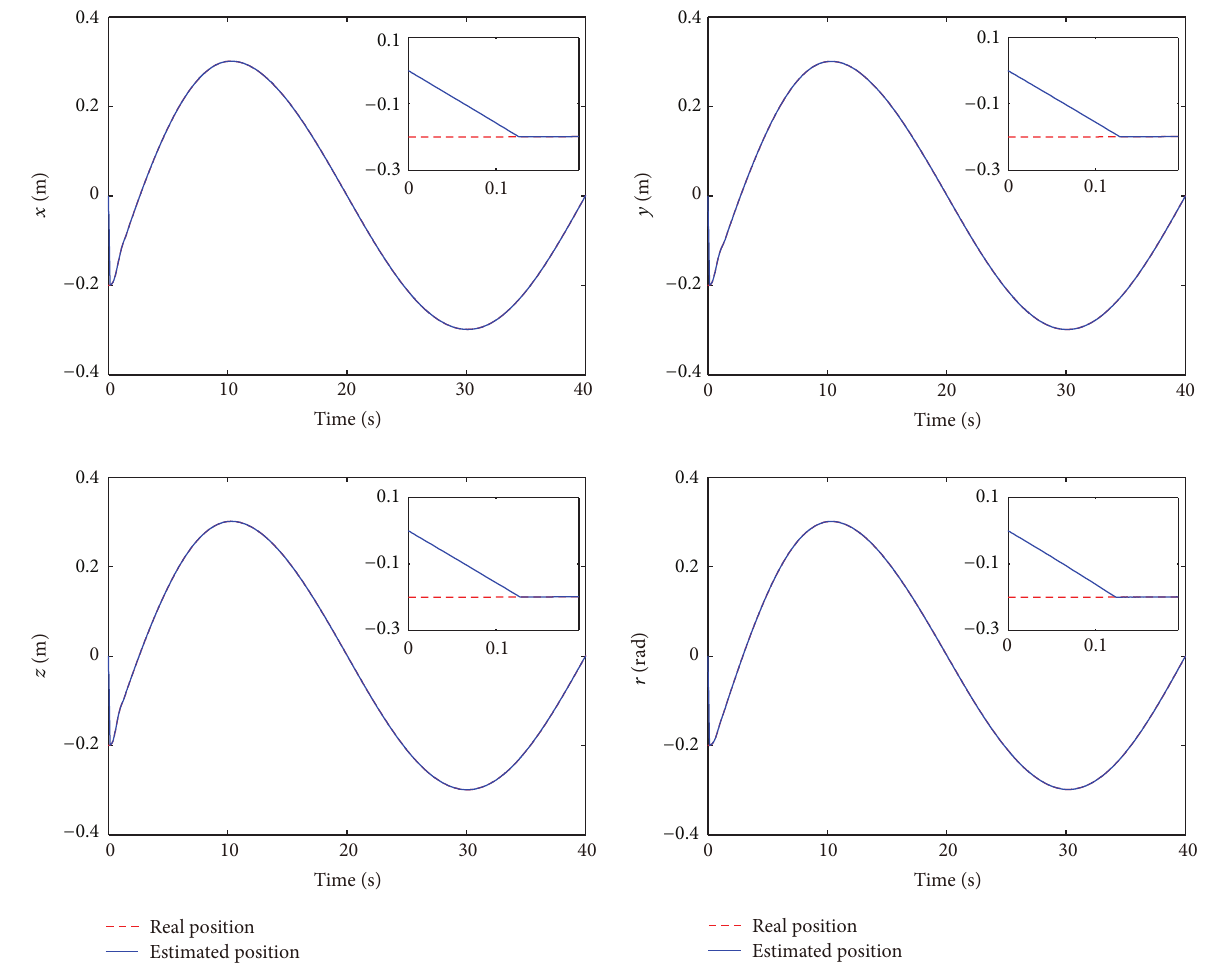
Figure 10: Estimated position and real position of output feedback FO-NTSMC with boundary